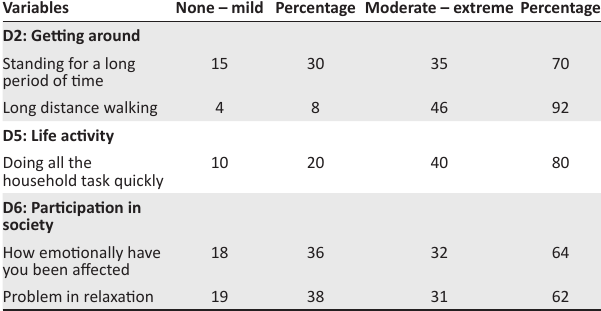
TABLE 3: Percentage of participants that had experienced difficulty in the World Health Organization Disability Assessment Schedule 2.0 sections. Variables TABLE 2: World Health Organization Disability Assessment Schedule 2.0 sections